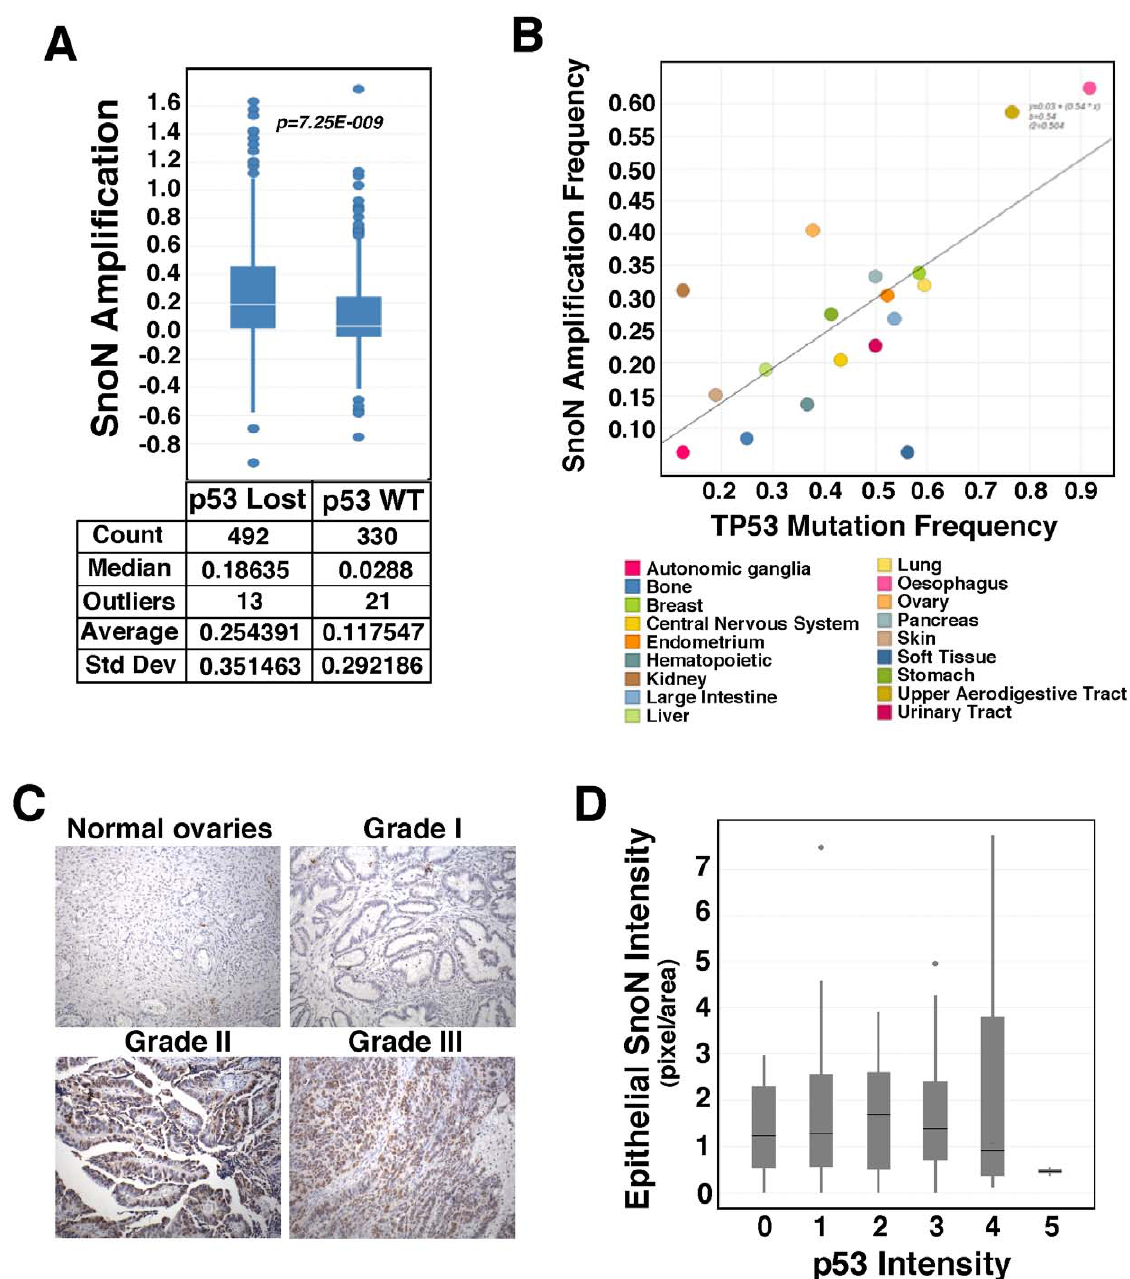
Figure 6. Elevated SnoN expression correlates with inactivation of p53 in human cancer cell lines but not in primary tumor tissues. A, 914 cancer cell lines from the Novartis CLE were classified based on their p53 gene status (lost or wild-type) as shown in the X-axis and their correlation with the copy numbers of SnoN as indicated in the Y-axis. A significant enrichment of SnoN amplification events in p53 mutant or deleted cell lines was identified (p=7.25E-009). B, Cell lines from the CLE were divided into 18 different tissue lineages as depicted by various colors, and the correlation between the frequency of TP53 mutation (X-axis) and frequency of SnoN amplification (Y-axis) was determined to be highly significant with a Pearson’s correlation coefficient of 0.7. C, Representative p53 immunohistochemical stain in normal ovarian tissue and ovarian adenocarcinoma of grade I, grade II, and grade III (Original magnification 6 20). D, Box plot depicting the intensity of epithelial SnoN expression (Y- axis) and p53 protein levels (as marked from 0 to 5, 0 being the lowest level in normal tissues and 5 being the highest). No significant correlation between the status of SnoN protein level and p53 inactivation was noted as measured by the Kruskal-Wallis test (p=0.817). doi:10.1371/journal.pone.0055794.g006 the stroma while decreased in the tumor epithelium, it is possible staining. The commercial anti-SnoN antibodies commonly used that by measuring overall SnoN levels by western blotting, one before showed a high background and sometimes detected might detect an increase in the overall expression of SnoN. Finally, nonspecific signals in our hands (data not shown). The anti-SnoN the difference could be due to the different antibodies used in the C-terminal peptide antibody has been carefully characterized, and